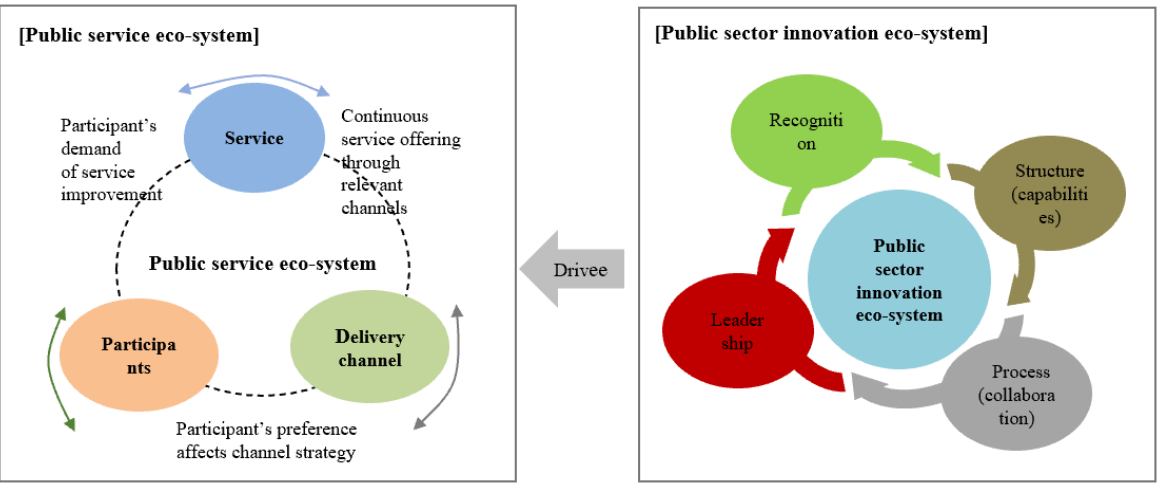
Figure 2. Ecosystem model of public service innovation (Bason 2018). Table 2 summarized that continuous innovation implementation and